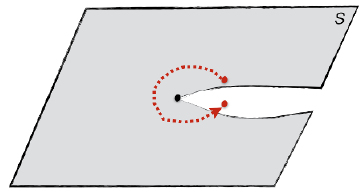
Figure 6 . Analytic continuation of eq. (2.5) through the branch